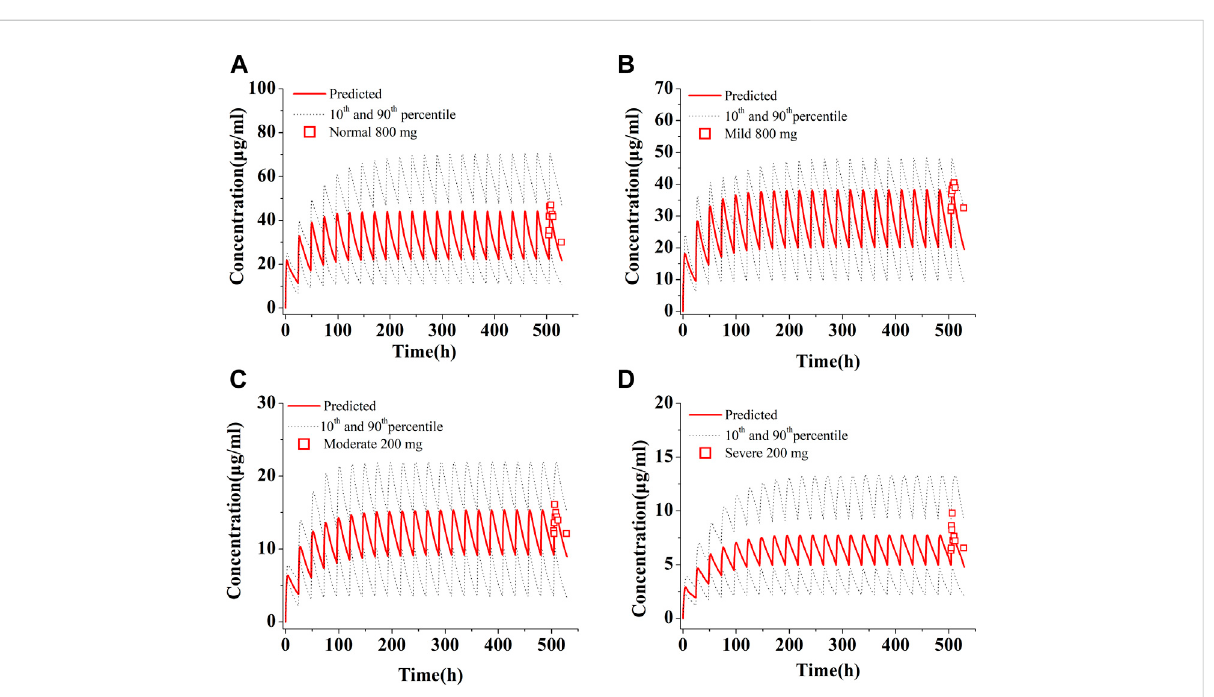
FIGURE 6 Simulations of pharmacokinetics of PAZ in patients with normal hepatic function (A) , with mild (B) , moderate (C) and severe (D) hepatic impairment. The red squares ( □ ) refer to clinically measured values in patients with normal hepatic function at 800 mg OD (A) , with mild hepatic impairment at 800 mg OD (B) , and with moderate (C) and severe (D) hepatic impairment at 200 mg OD. All simulations were run at repeated daily doses for a consecutive 21